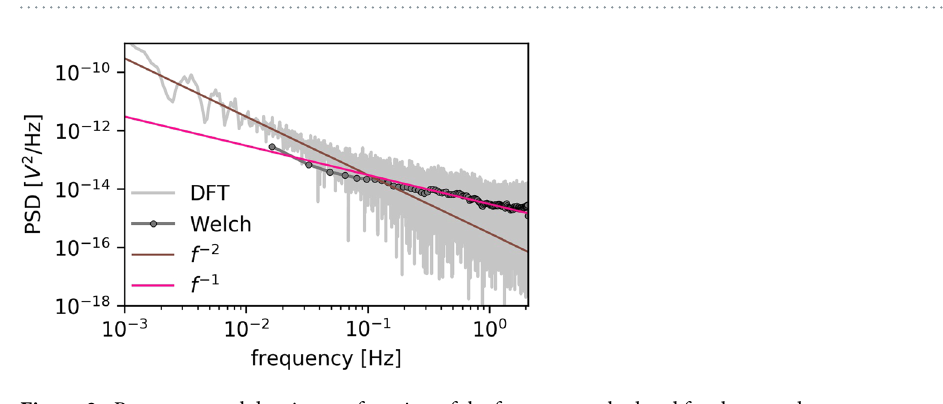
Figure 1. Raw time series of the electromotive force registered in the experiment. Data are visually divided into two parts. At the beginning of the experiment (solid grey line), the system has to settle down; hence, this part of the data represents transient effects. The rest of the plot (blue solid line) represents a minimally stable region of the fluctuating force U .